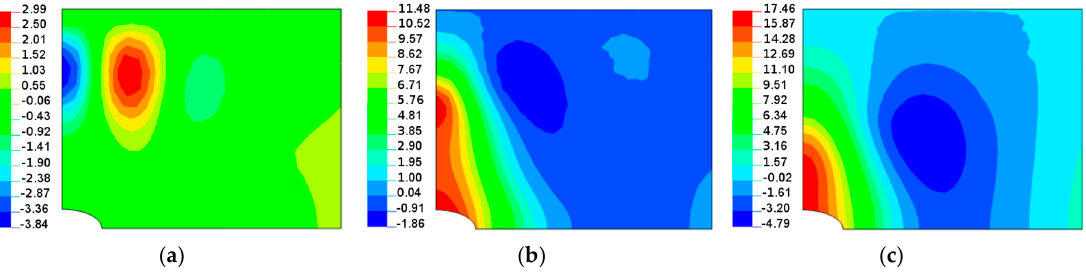
Figure 13. Buckling modes (normal deflections) for a rectangular plate ( L x / L y = 1.25) with the elliptical horizontal hole, 2 b / L x = 0.16, b / a = 2: ( a ) isotropy E 1 / E 2 = 1; ( b ) E 1 / E 2 = 2 θ = 30°; ( c ) E 1 / E 2 = 2 θ = 60°.